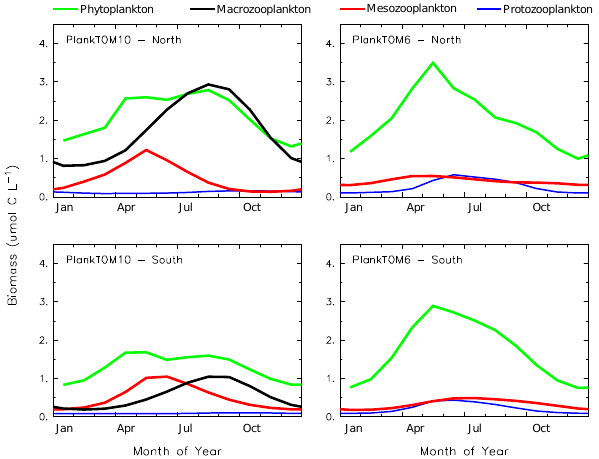
Figure 13. Mean surface concentrations of the biomass of phy- toplankton (green), macrozooplankton (black), mesozooplankton (red), and protozooplankton (blue). Results are shown for (left) the PlankTOM10 model and (right) the PlankTOM6 model, and for (top) the north and (bottom) the south. All data are averaged for 1998–2009, and between 30 and 55 ◦ latitude in both hemispheres: 140–240 ◦ E in the north and 140–290 ◦ E in the south, as highlighted in Fig.